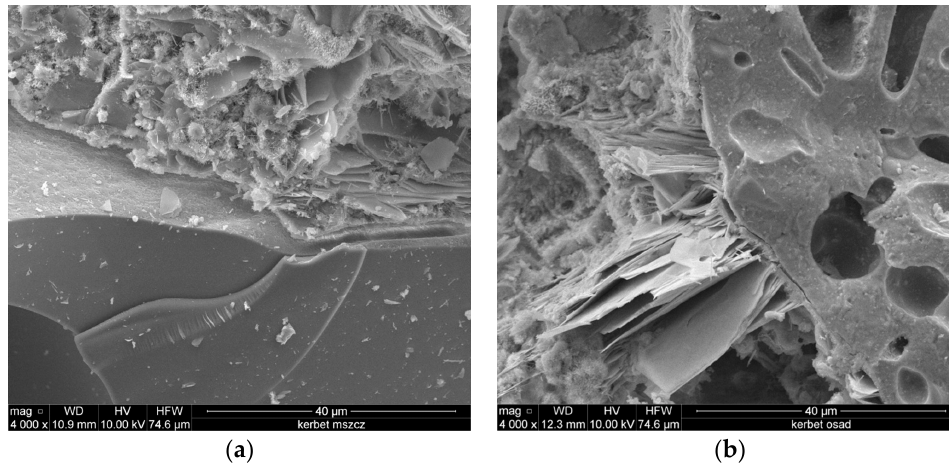
Figure 7. SEM investigation in contact point between: ( a ) lightweight aggregates from Mszczonów and cement mortar; and ( b ) lightweight aggregates with sewage sludge and cement mortar.